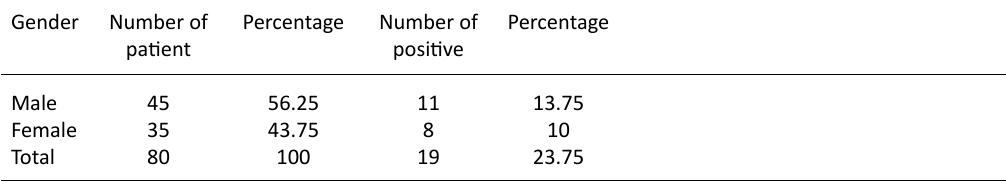
Table 2. Distributions of HIV seropositive patients with positivity according to gender Gender Number of Percentage Number of Percentage